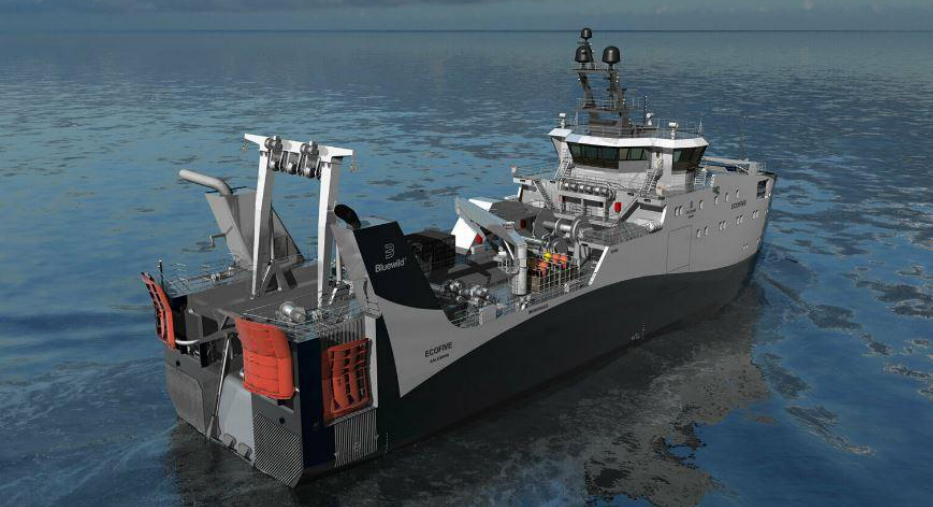
Figure 15. Image of the hybrid propulsion trawler ULSTEIN FX101 [79].